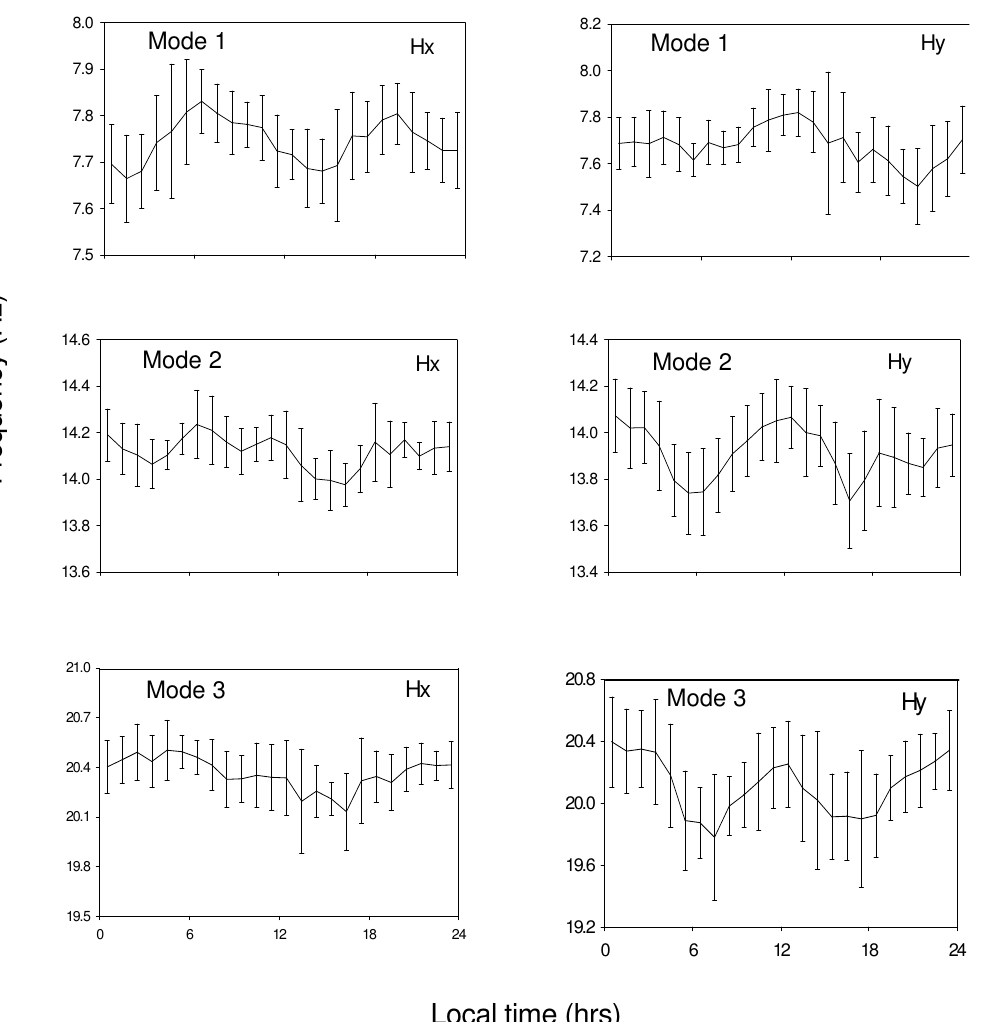
Fig. 5. The average diurnal frequency variation observed in the first three SR modes frequency of magnetic field components during, 10 March–23 May 2006. Error bar indicates standard